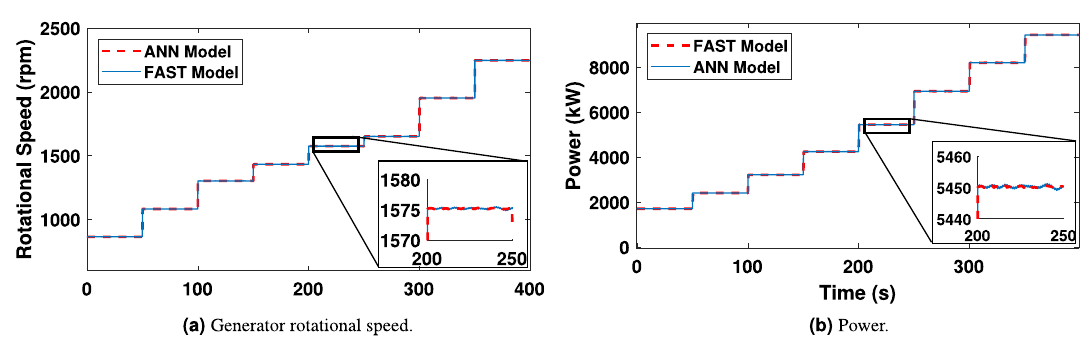
Figure 21. Generator rotational speed and power in irregular wave